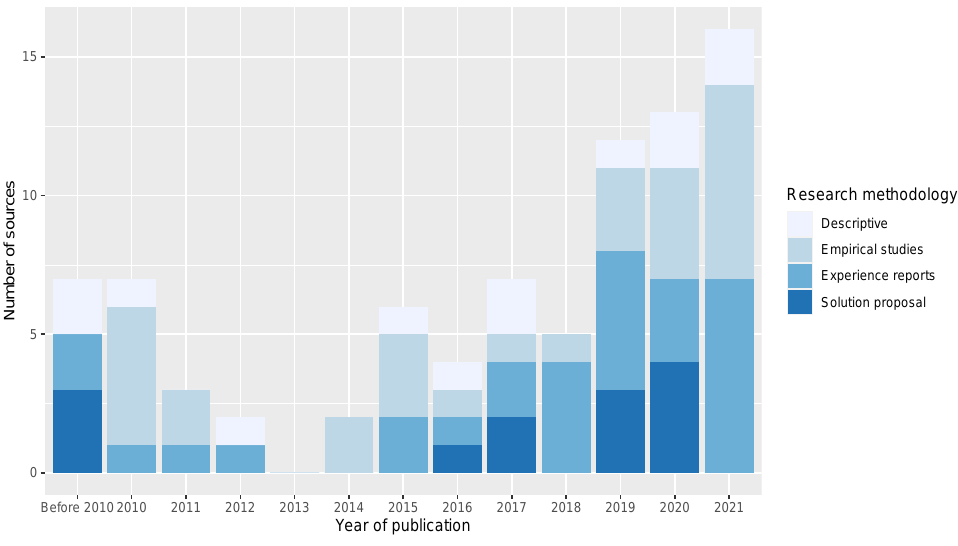
Figure 9. Number of white literature sources per year by research